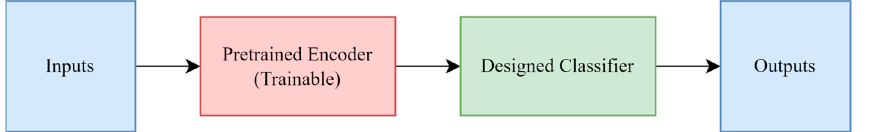
Figure 8. A simple presentation of the classifier included by the retrainable encoder, which is the only difference, compared to Figure 4.